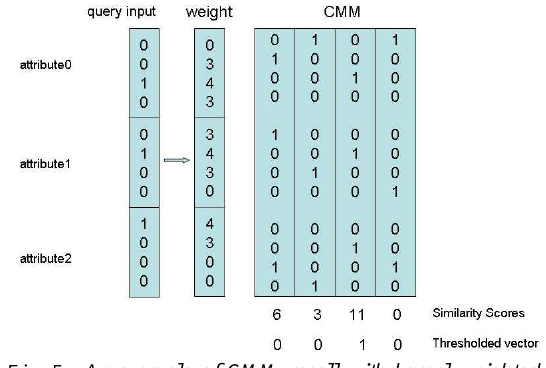
Fig. 5. An example of CMM recall with kernel weighted inputs.